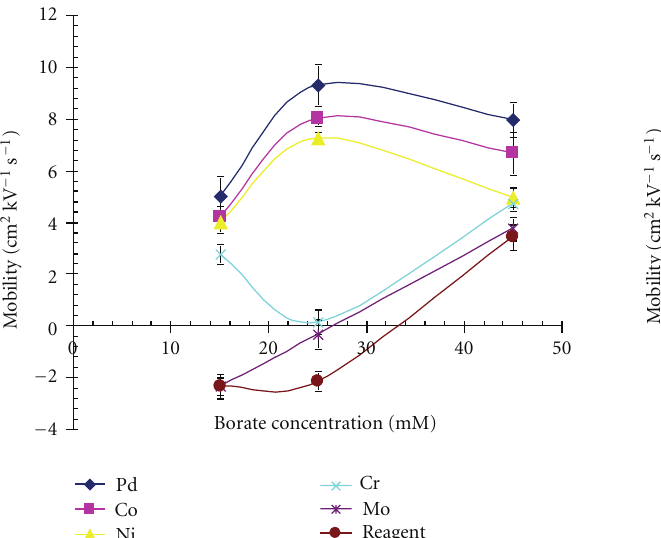
Figure 4: The e ff ect of the amount of organic modifier on the migration velocity of metal complexes, with respect to